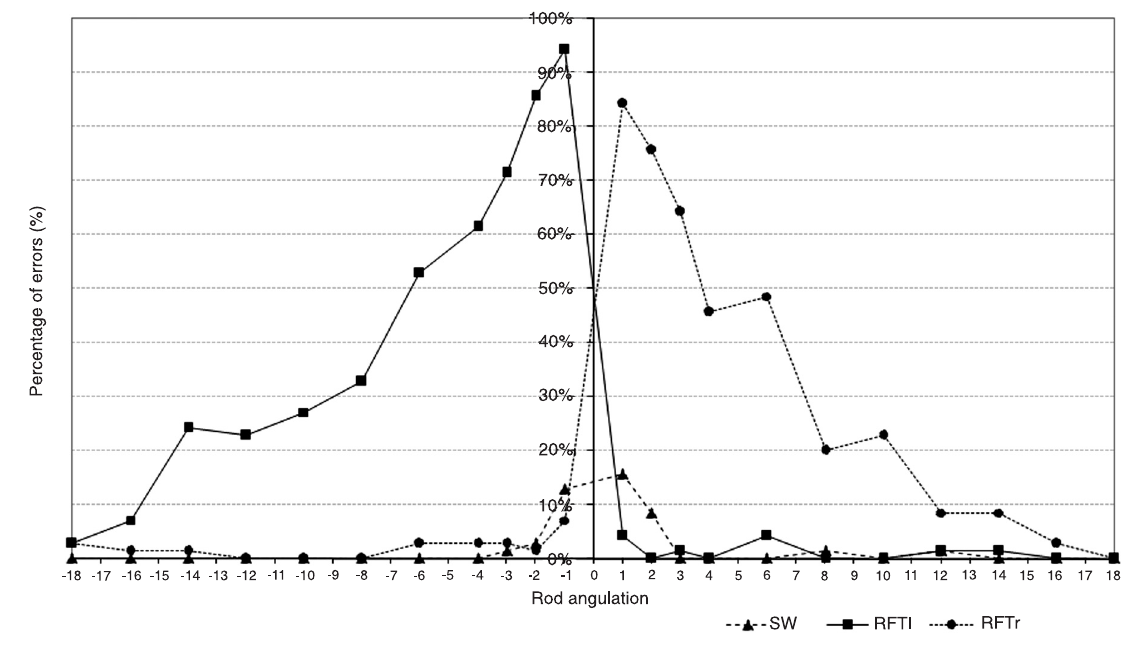
Figure 4. Percentage of errors per rod angle in SVV and RFT in field-dependent (FD) subjects (N = 14). SVV = subjective visual vertical; RFTl = rod and frame test, frame tilted to the left; RFTr = rod and frame test, frame tilted to the right.